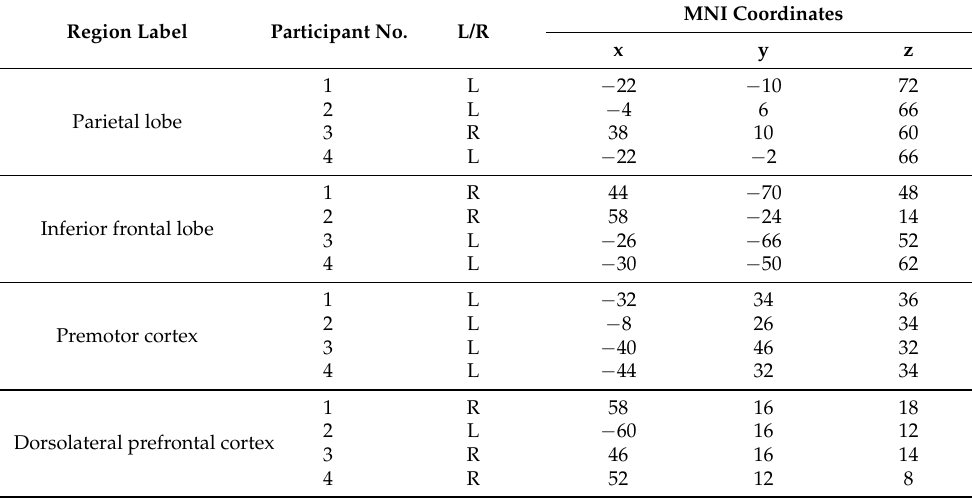
Table 1. Peak coordinates with the most differences in activation. Region